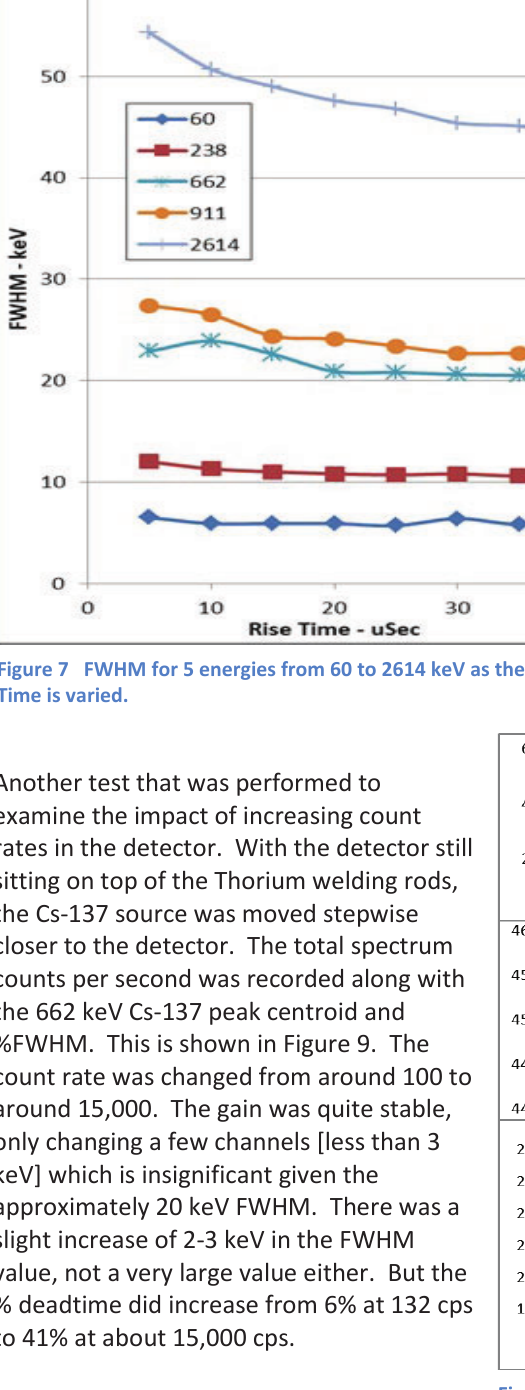
Figure 9 Change in %DeadTime, peak centroid, and FWHM as the total CPS was